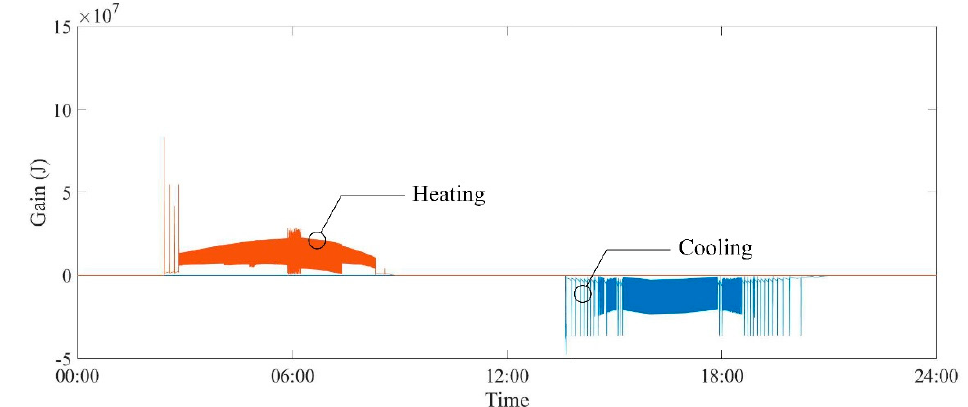
Figure 11. Energy use by FIS at an abnormal condition.